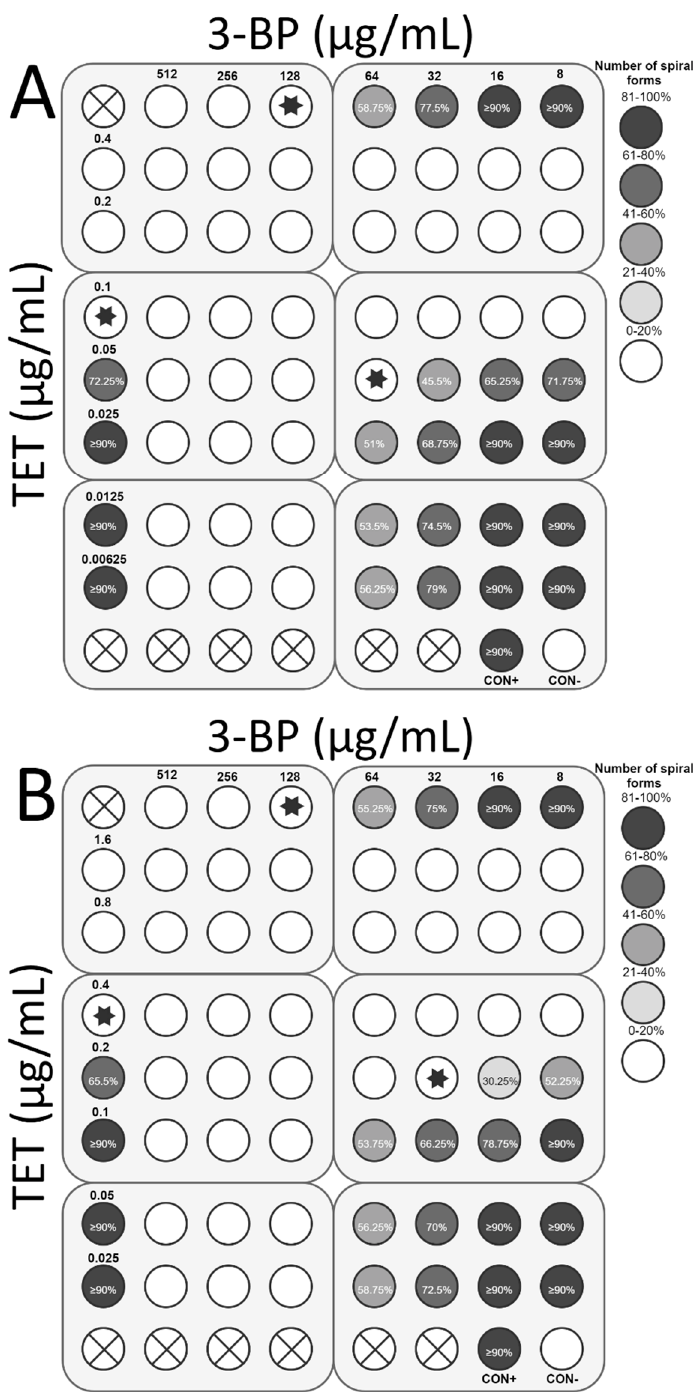
Figure 9. The antibacterial and morphological effects of 3-Bromopyruvate (3-BP), tetracycline (TET), and combinations of both against H. pylori Tx30a and 7143 strains. The existence of the interaction in the antimicrobial activity of 3-BP with CLR was determined against ( A ) the reference antibiotic-susceptible H. pylori Tx30a and ( B ) the clinical double-resistant H. pylori 7143 strain. The white circles indicate the wells in which the number of spiral forms was ≤ 15%, while the white circles with a cross in the middle indicate empty wells. Using asterisks, the wells with the MICs of the tested substances were marked, whereas in the case of the interaction verifications, they indicate the lowest FIC. Abbreviations: 3-BP, 3-Bromopyruvate; TET, Tetracycline; CON+, Positive control; and CON − , Negative control.